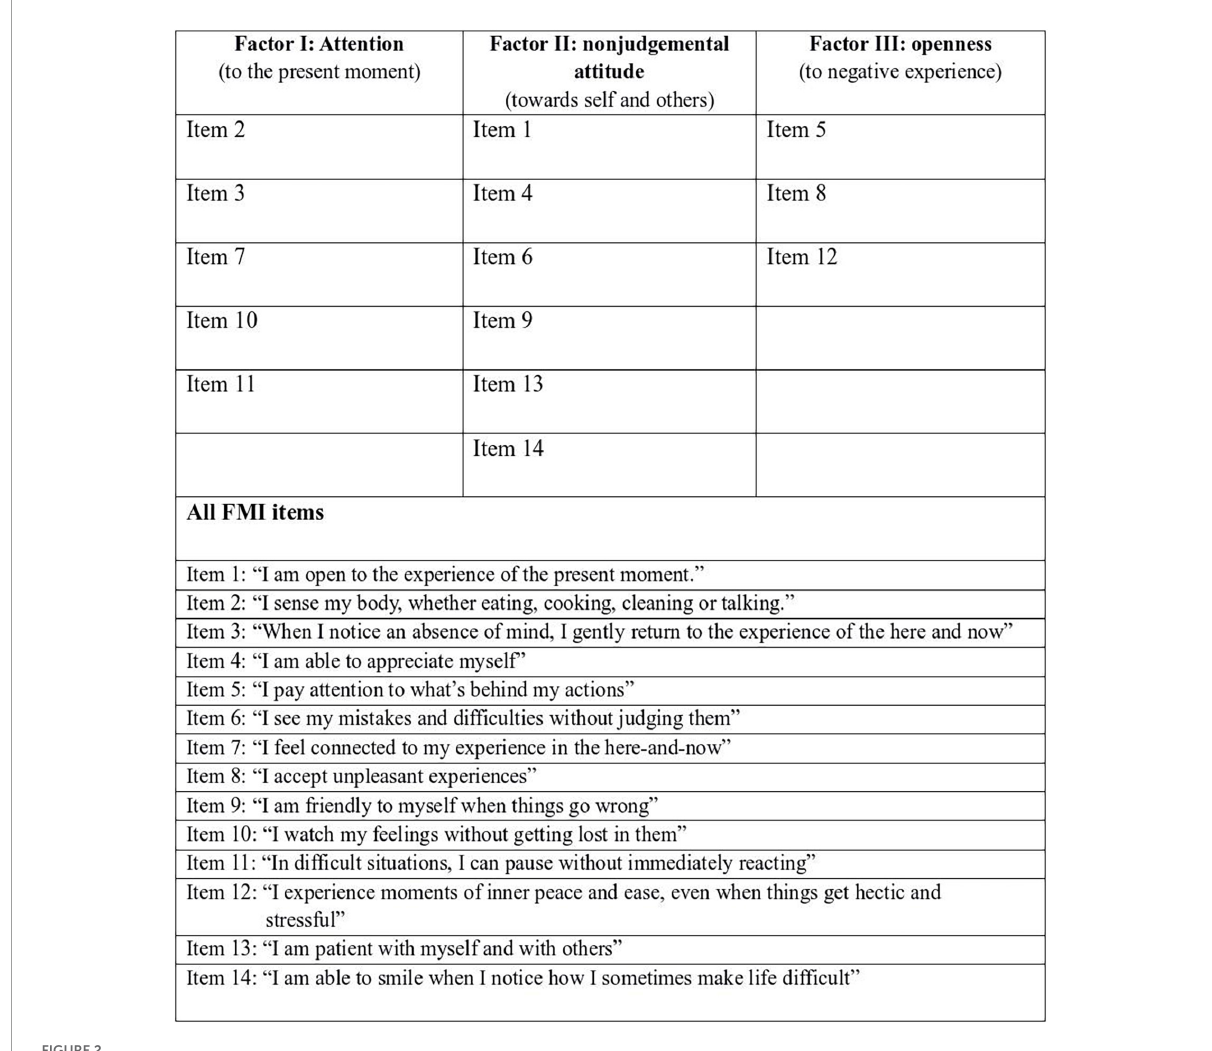
FIGURE2 Items and factors of FMI (Freiburger Mindfulness